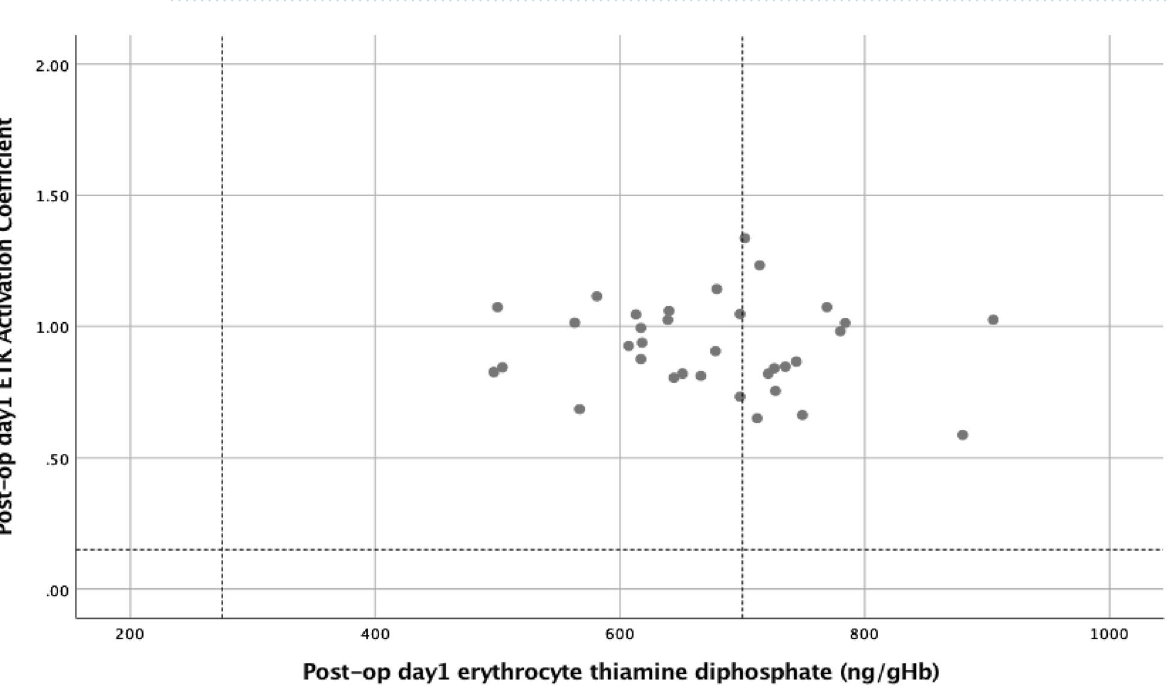
Figure 2. The relationship between day 1 post-operative erythrocyte thiamine diphosphate and erythrocyte transketolase activation coefficient (ETK activation coefficient: erythrocyte transketolase activation